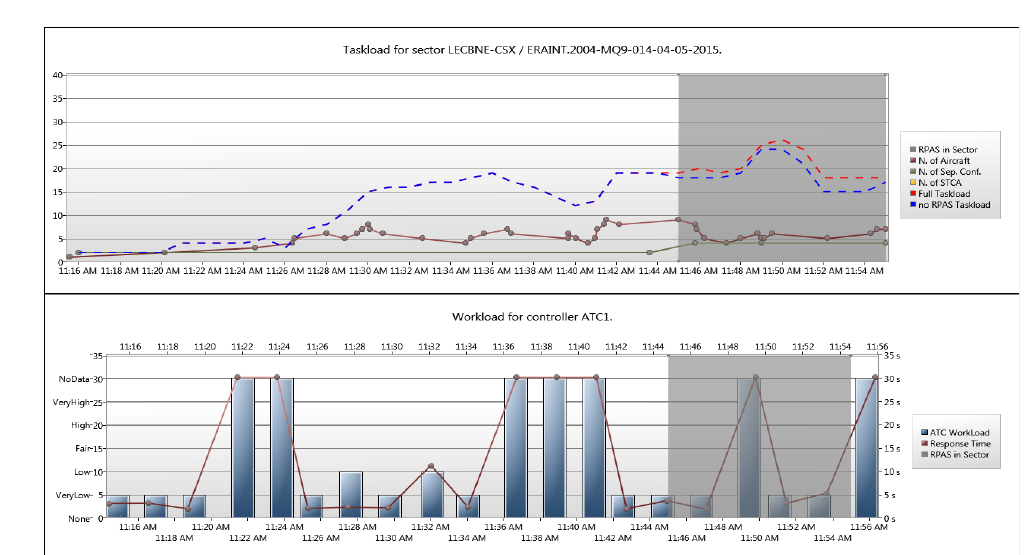
Figure 8. Sector LECBNE, CAPAN task load, and ISA workload,